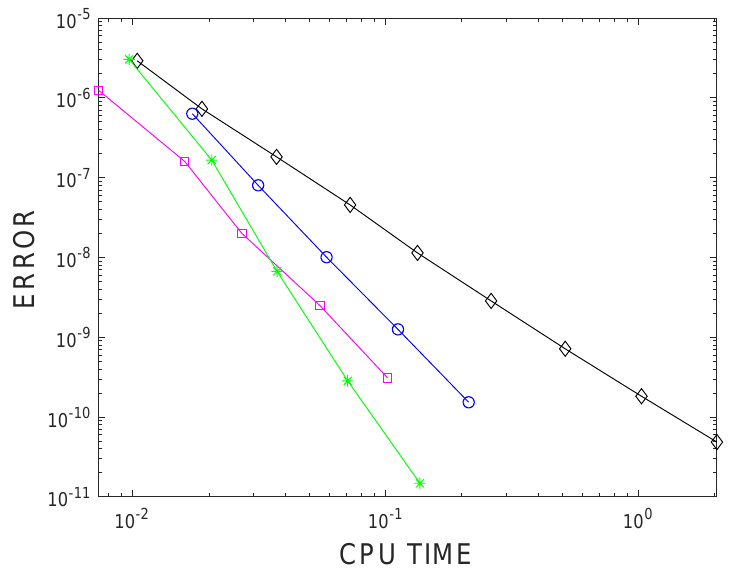
Figure 1. Graph for the global error in the solution with RK2 ( (cid:5) , black), RK3 ( (cid:3) , magenta), RK4 ( ∗ , green), and RKN3 (o,